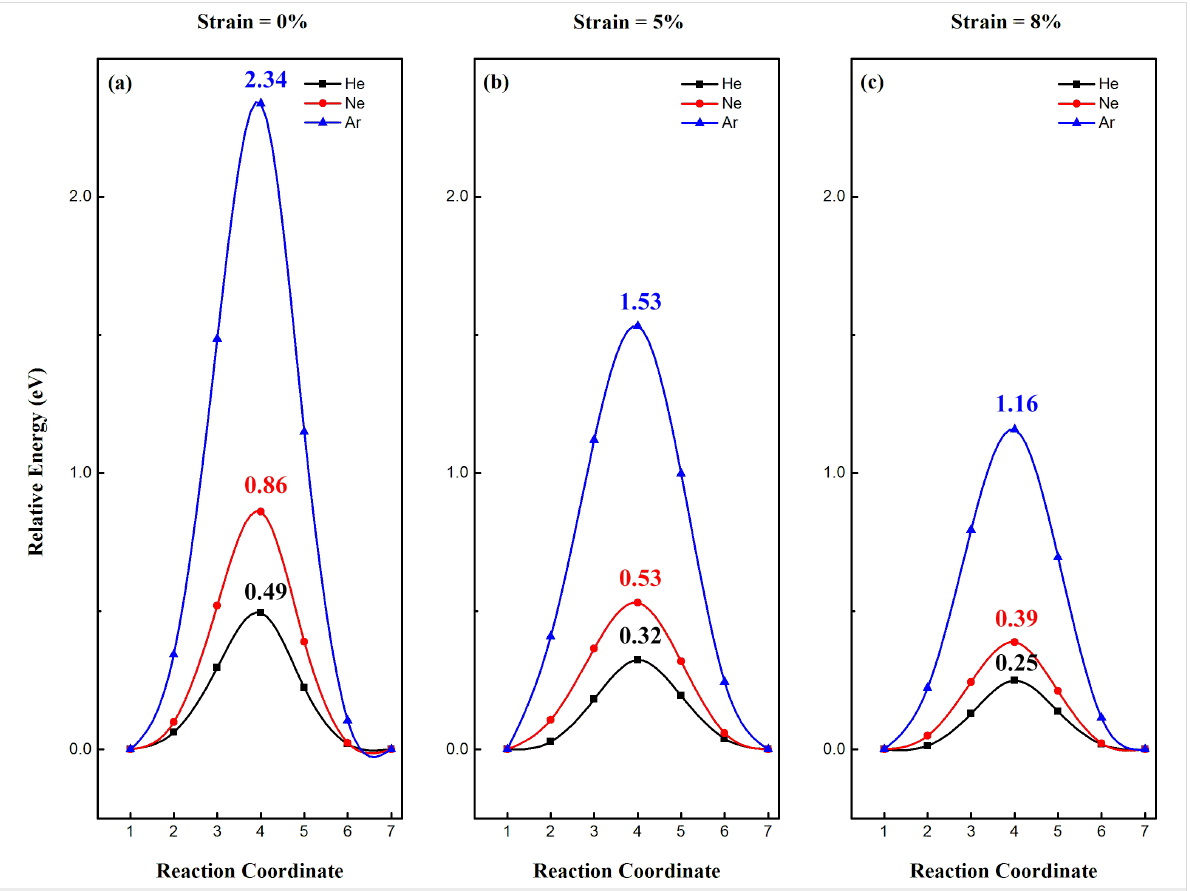
Figure 4: Minimum pathway for noble gases (He, Ne and Ar) passing through a 2D SnF lattice under (a) 0%, (b) 5% and (c) 8% strain.